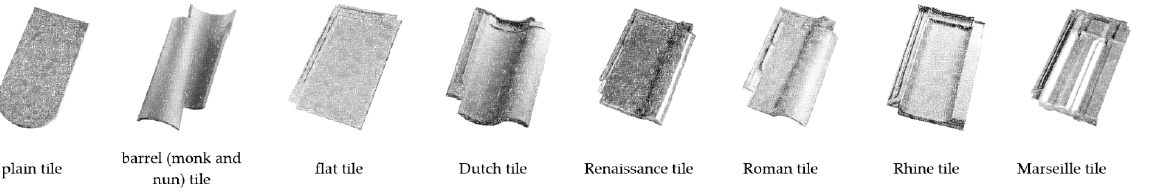
Figure 1. Examples of different roof tiles.